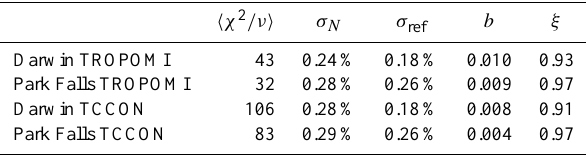
Table 2. Fit diagnostics of the CH 4 column retrievals in the 4190– 4340cm − 1 range, for the original (TCCON) and for the TROPOMI resolution.